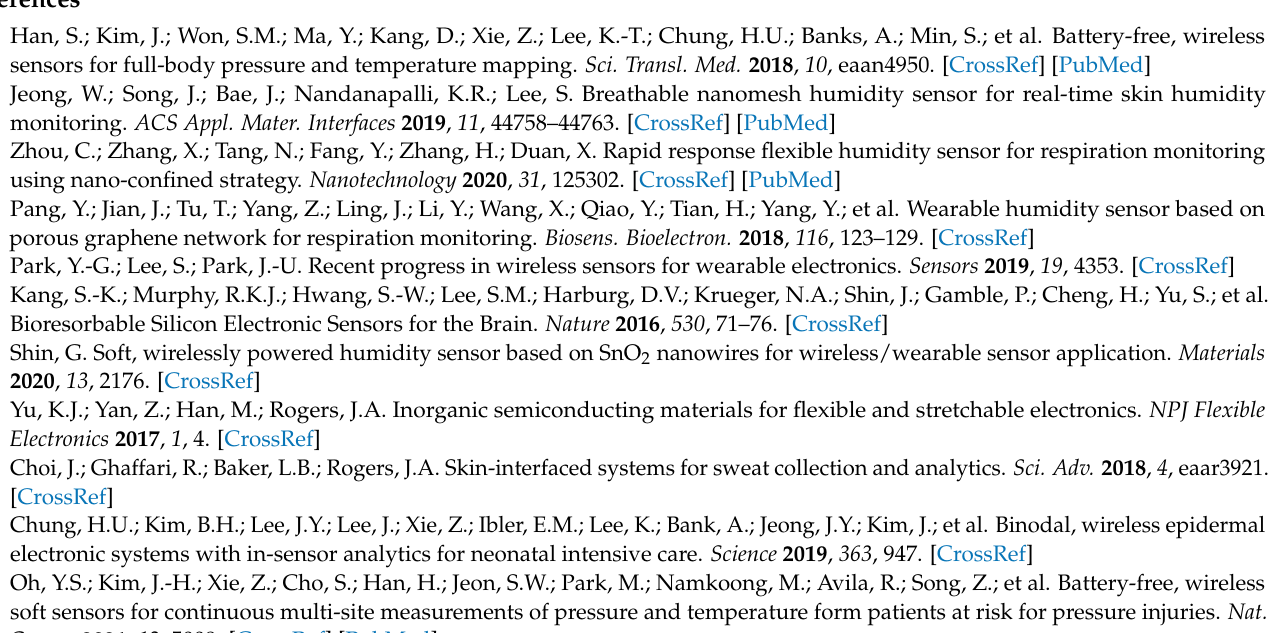
Figure A3. As-grown SnO 2 nanowires. ( a ) Scanning electron microscopy (SEM) image and energy- dispersive X-ray spectroscopy data (inset). ( b ) X-ray diffraction (XRD) graph of rutile SnO 2 nan- owires.